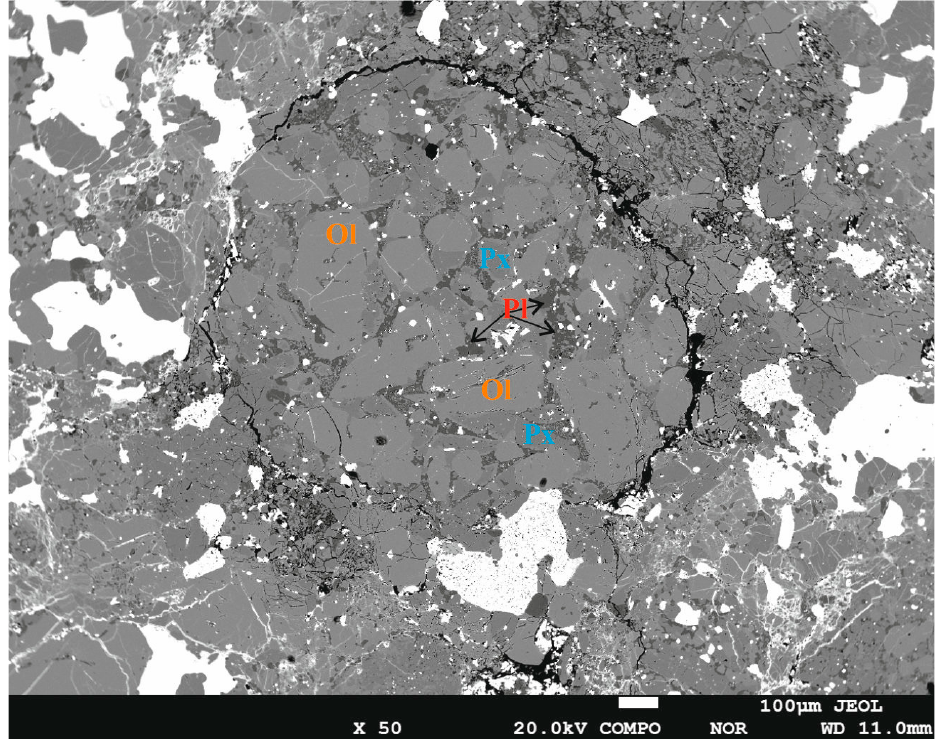
Figure 5. BSE image of 1POP-4 chondrule from Kargapole meteorite. Olivine in the chondrule is present as coarse crystals of forsterite composition. Olivine grains in the chondrule and in the meteorite matrix are highly fractured.